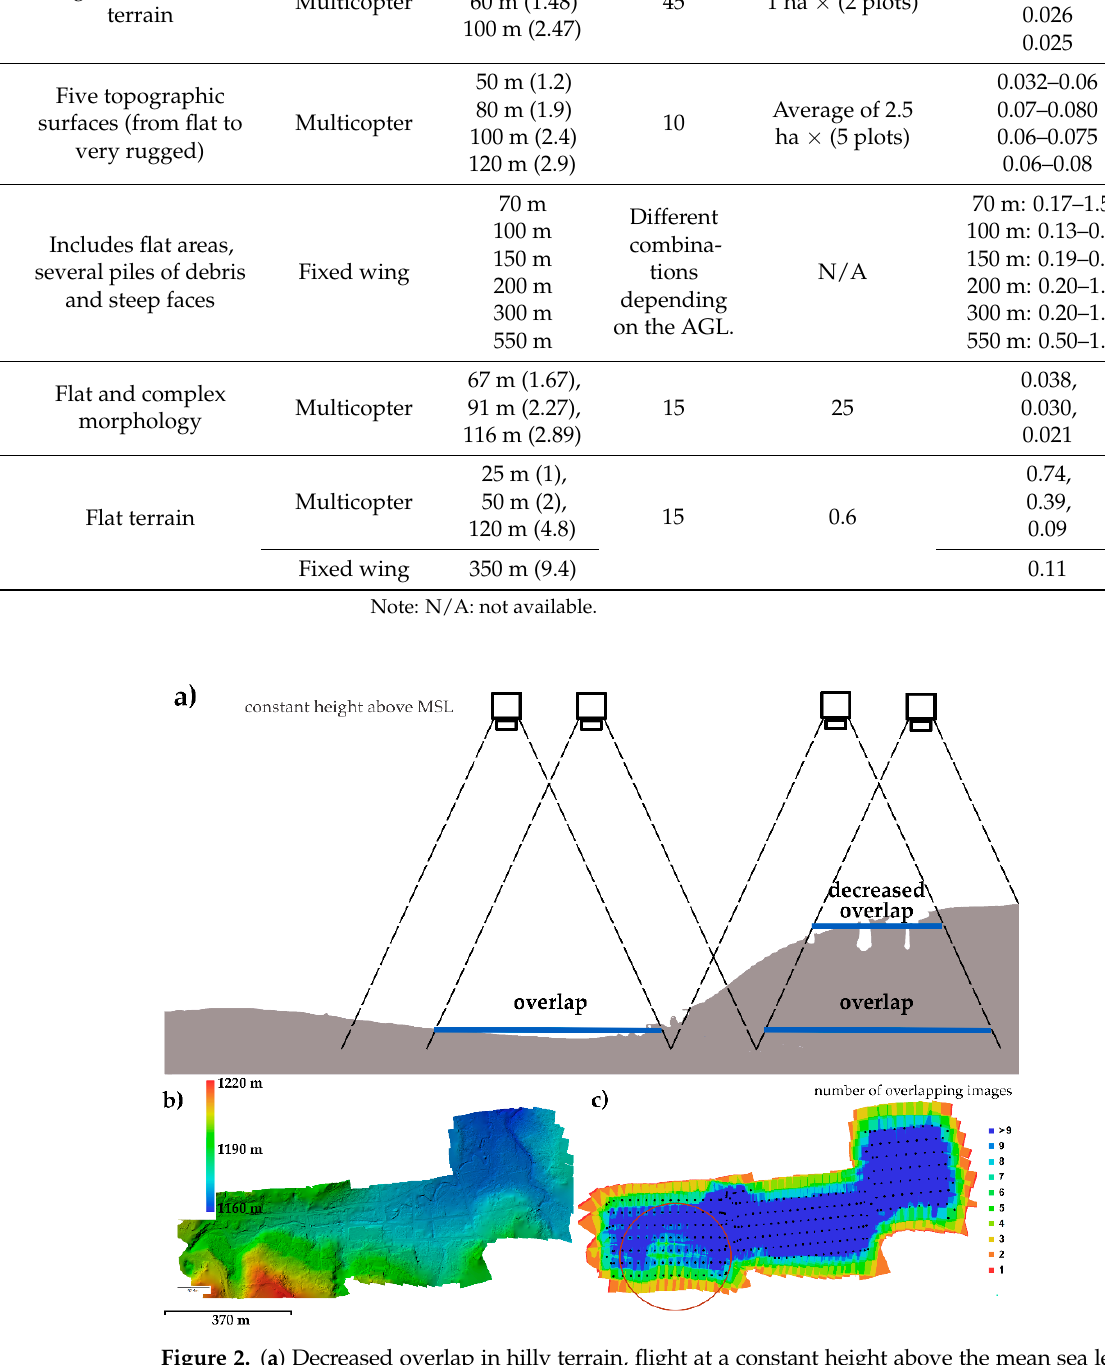
Figure 2. ( a ) Decreased overlap in hilly terrain, flight at a constant height above the mean sea level (MSL), ( b ) digital terrain model (DTM) generated from images acquired at a constant height above the MSL, and ( c ) the number of overlapping images with fewer overlapping images in the highest areas.